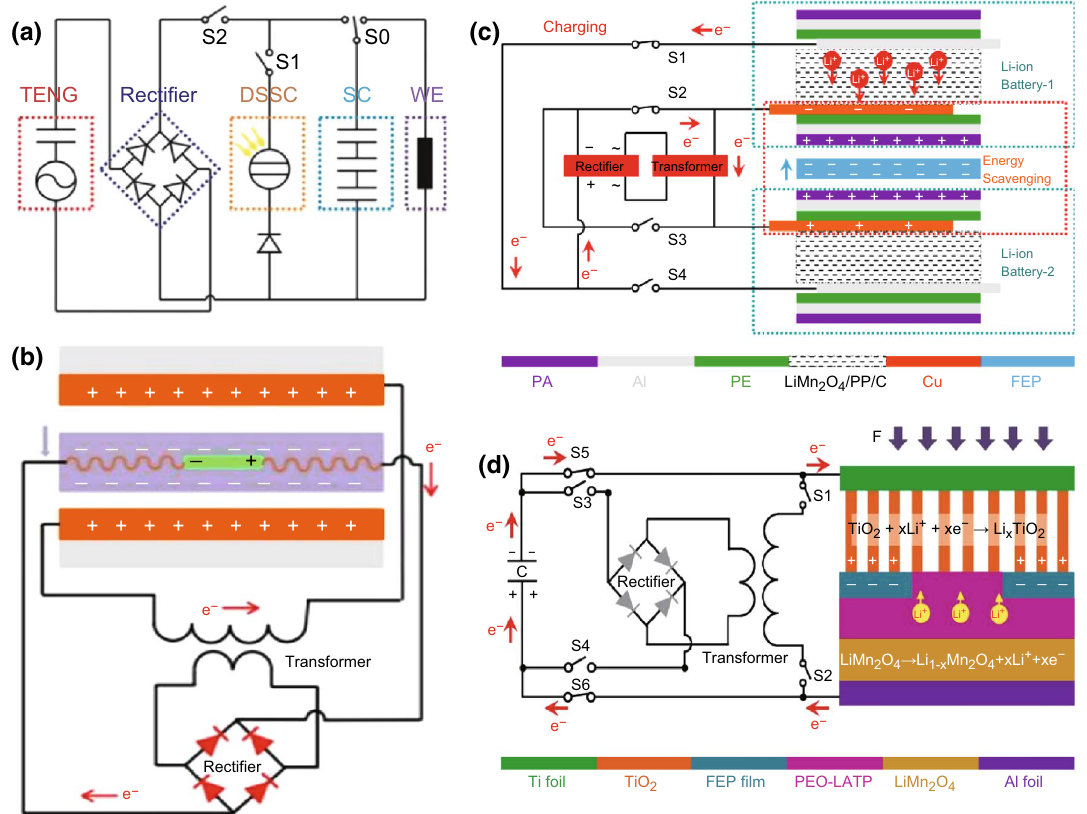
Fig. 8 a Circuit diagram of the self‑charging powered textile for wearable electronics (WE). Reprinted with permission from Ref. [23]. b Implanting an SLB into a triboelectric nanogenerator. Reprinted with permission from Ref. [25]. c Schematic diagram of self‑charging process for the Li‑ion batteries, distinctly showing the flow of electrons in the circuit. Reprinted with permission from Ref. [19]. d Schematic illustration of the electric storage process from the external capacitor to the convoluted power device as an SLB. Reprinted with permission from Ref.